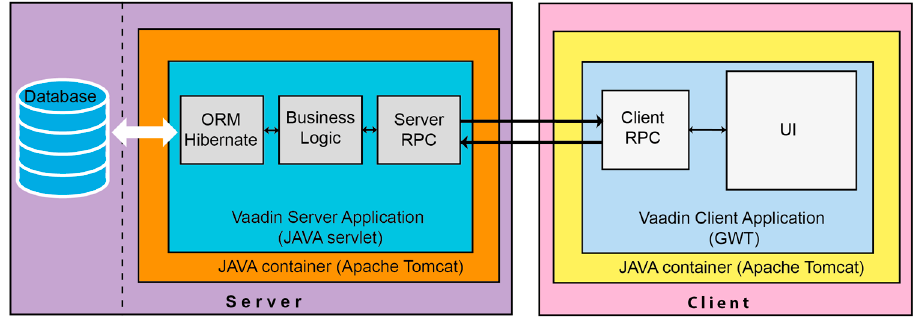
Figure 10. Scheme of the technical structure (adapted from Šašinka et al. [20]).